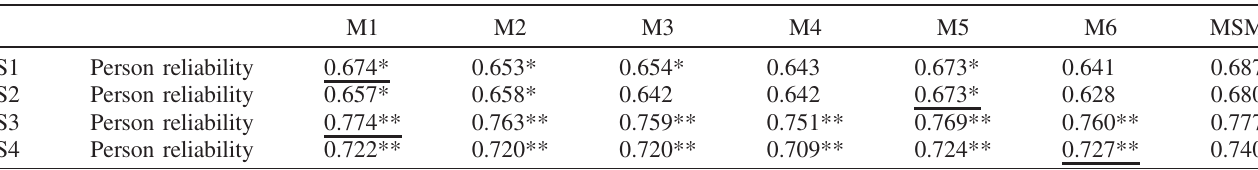
TABLE III. Model fitting person reliability coefficients. For M1 – M6, the highest reliability coefficients of each population are underlined. The reliability coefficients above the “ minimally acceptable ” level ( > 0 . 65 ) are marked with an asterisk (*) and the reliability coefficients above the “ respectable ” level ( > 0 . 70 ) are marked with two asterisks (**). MSM, which will be introduced later, is a new Rasch model based on a mixed scoring method. Statistical analysis of the reliability measures is discussed in the Supplemental Material